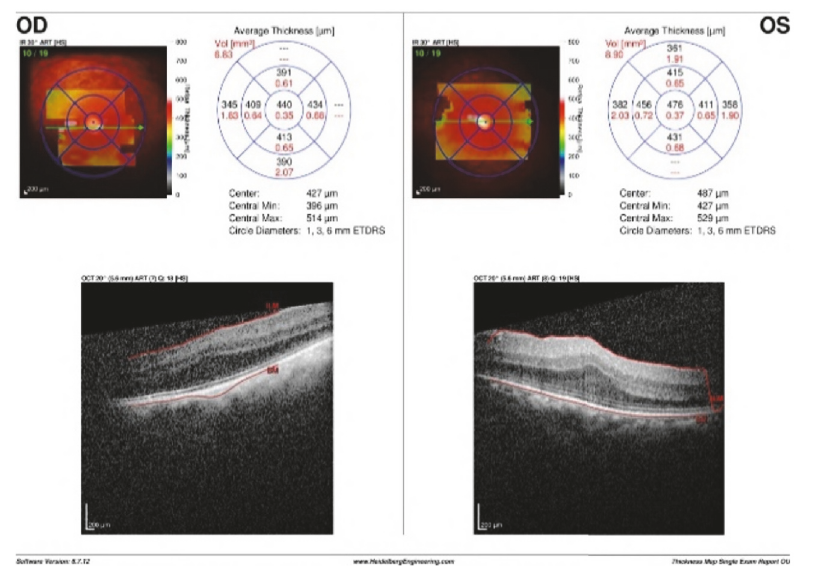
Figure 1: Spectral domain optical coherence tomography of both maculae and horizontal cut, depicting an inverted U-shaped papillomacular folds of the neurosensory retina, greater in the left eye with preservation of the majority of outer retinal layers.